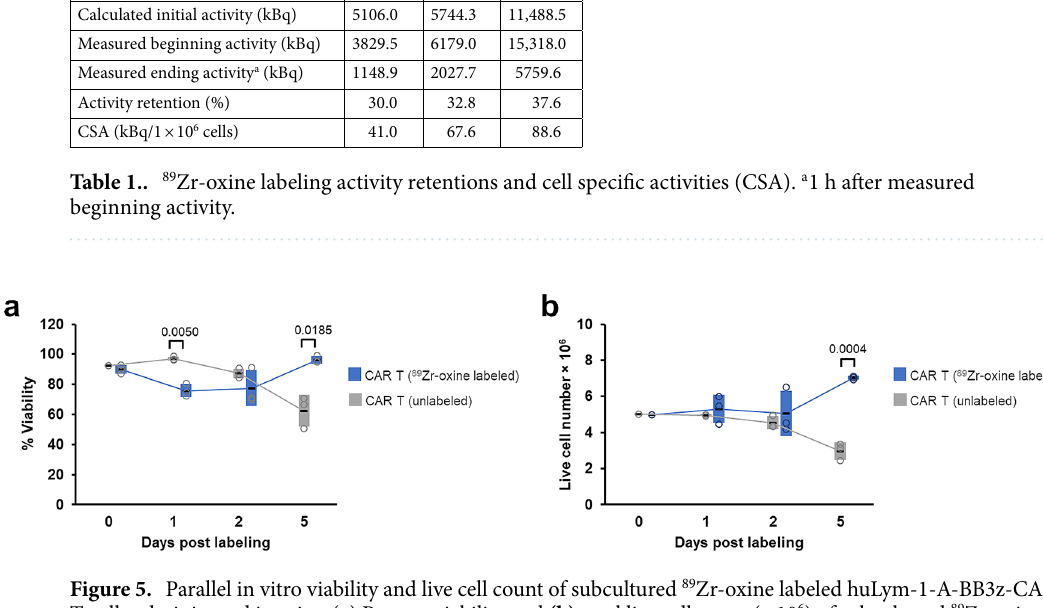
Figure 5. Parallel in vitro viability and live cell count of subcultured 89 Zr-oxine labeled huLym-1-A-BB3z-CAR T-cells administered in mice. ( a ) Percent viability and (b) total live cell count (× 10 6 ) of subcultured 89 Zr-oxine labeled and unlabeled CAR T-cells from the same cell batch administered to live mice. Viability and live cell count plots show dash lines as means, colored bars as SD, and open circles as individual data points. Statistically significant findings between comparisons are indicated with p values above brackets. A value of p < 0.05 was used to indicate statistical